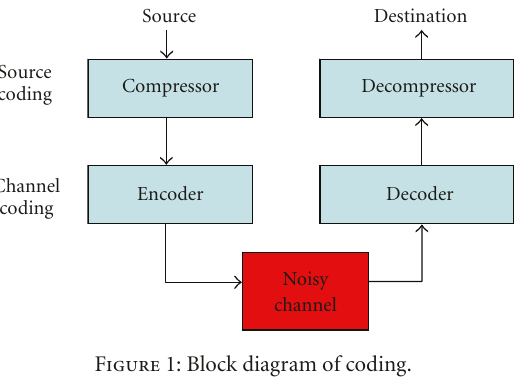
Figure 1: Block diagram of coding.